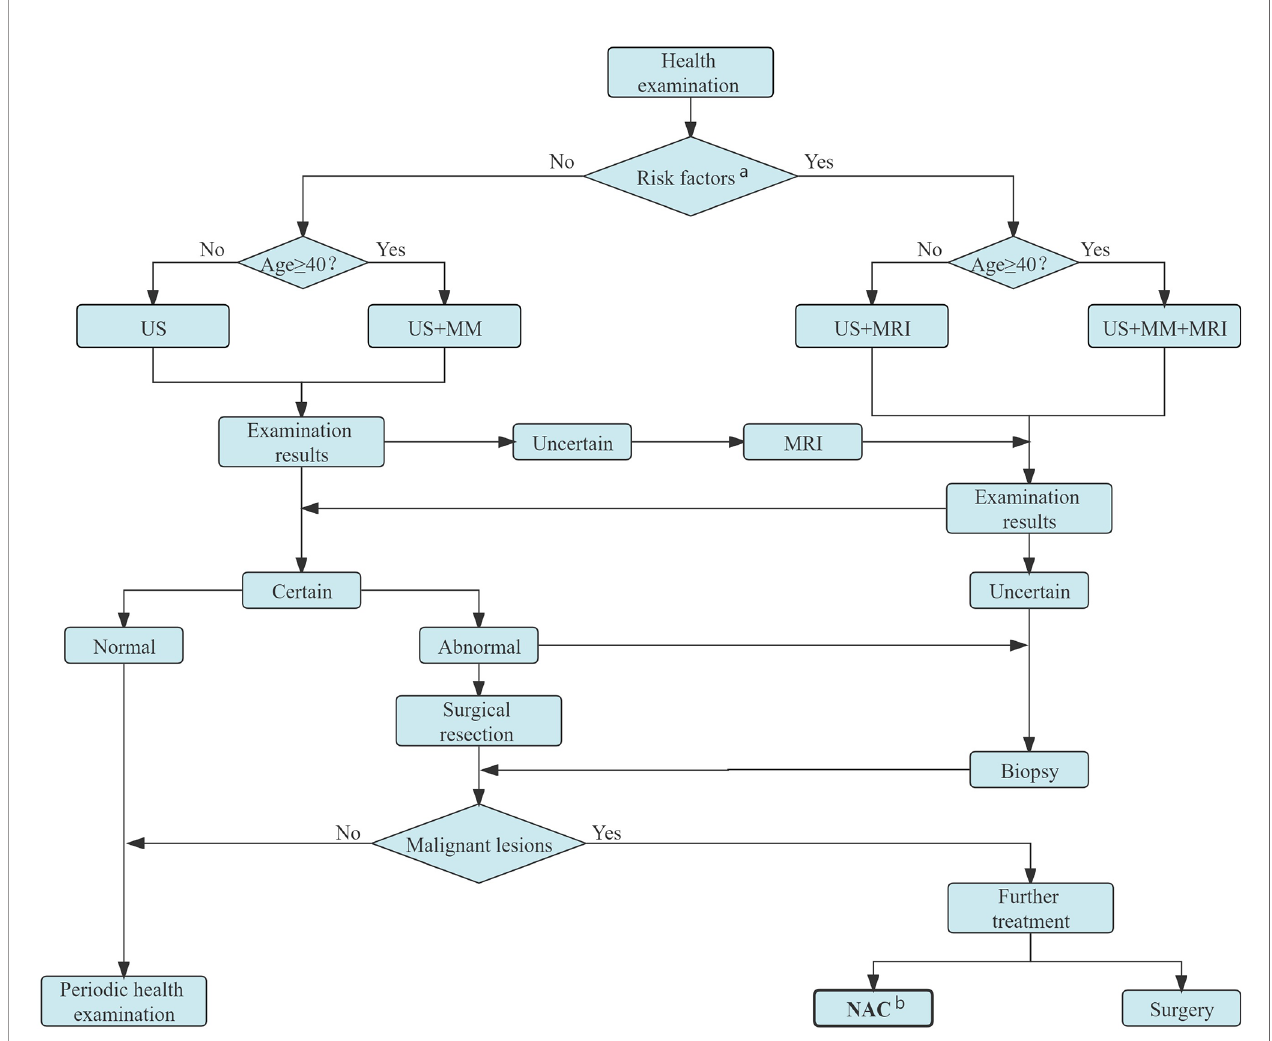
FIGURE 1 | Candidates for NAC screening process in Yunnan Cancer Hospital. a Persons with obvious genetic tendency of breast cancer, history of LCIS or ductal or lobular dysplasia, or who experienced chest radiation before age 30. b Candidates for NAC: patients with inoperable breast cancer (IBC, bulky or matted cN2 axillary nodes, cN3 nodal disease, cT4 tumors), NAC is preferred for those with inoperable breast cancer (HER2-positive disease and TNBC if cT ≥ 2 or cN ≥ 1, large primary tumor relative to breast size in a patient who desires breast conservation, cN+ disease is likely to become cN0 with preoperative systemic therapy) and patients in whom de fi nitive surgery may be delayed. US, ultrasound; MM, mammography; MRI, magnetic resonance imaging; NAC, neoadjuvant chemotherapy; LCIS, lobular carcinoma in situ; IBC, in fl ammatory breast cancer; HER2, human epidermal growth factor receptor